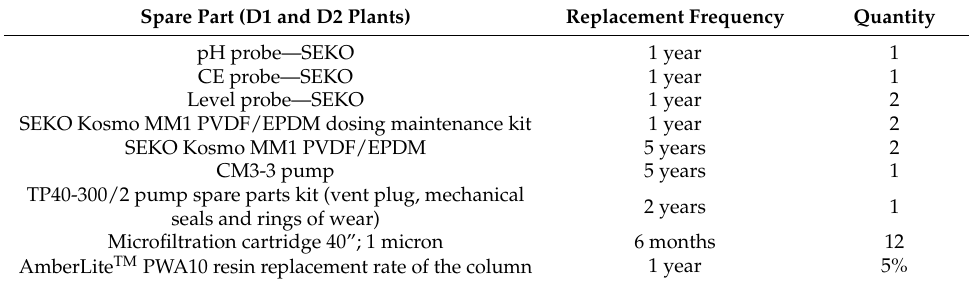
Table 3. Spare parts needed for the two IX systems considered in this